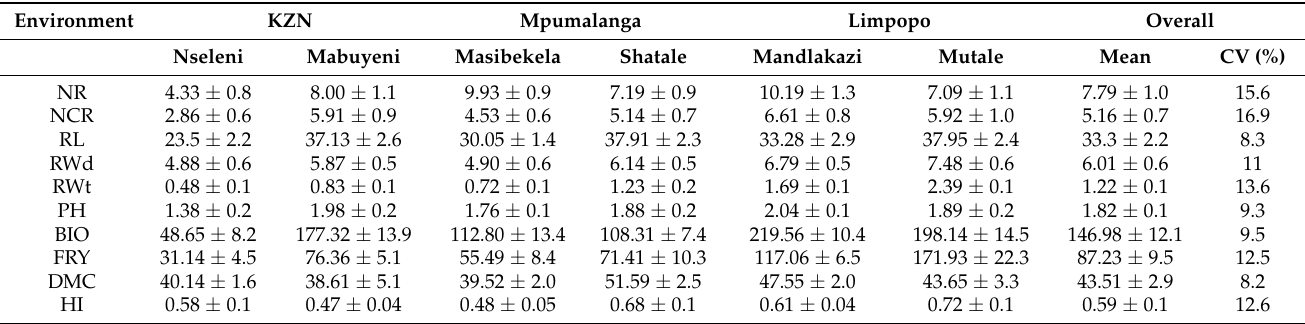
Table 2. Overall environment means, standard deviation and coefficient of variability of 10 agronomic traits measured on selected cassava genotypes evaluated in six environments.